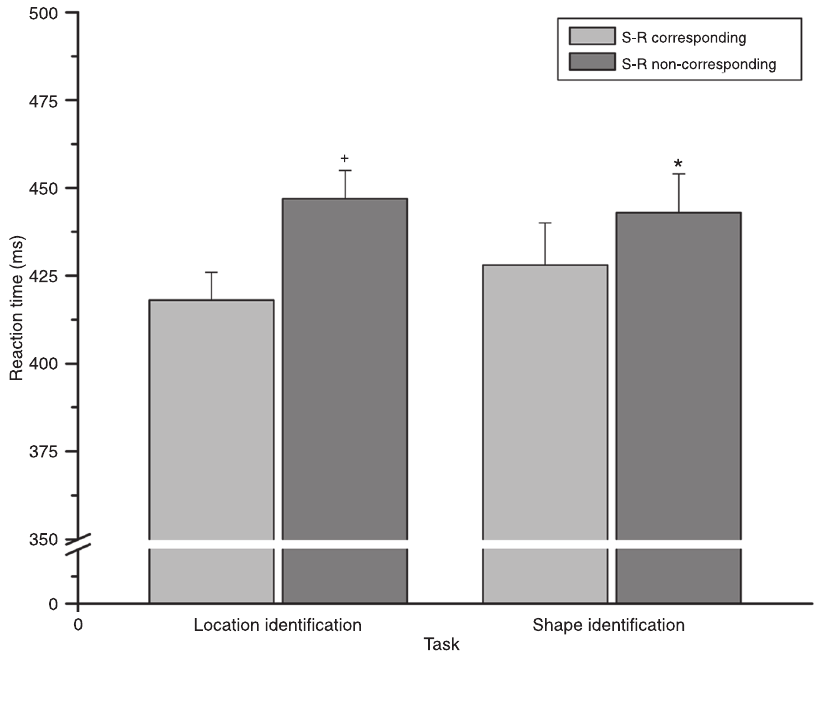
Figure 3. Reaction time in the warn- ing stimulus absent and present trials in the stimulus-response (S-R) side corresponding and non-corresponding conditions across the six stimulus on - set asynchronies without separation of the location and the shape identification task data. Data are reported as means ± SEM for 12 subjects. Data analysis was performed by repeated measures analysis of variance followed by the Tukey test. *0.050 > P ≥ 0.010; + 0.010 > P ≥ 0.001; # P <